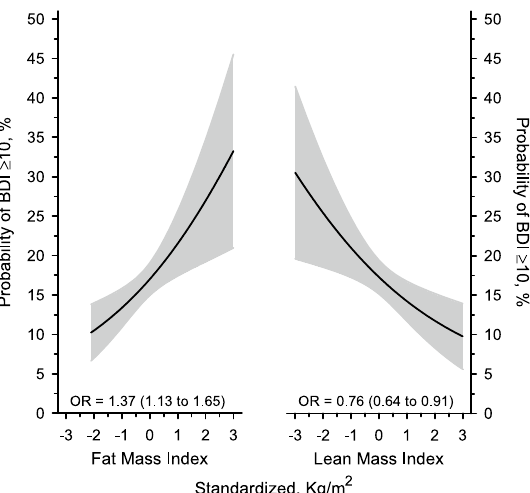
Figure 3. Relationship between BDI ≥ 10 according to body composition. BDI beck depression inventory, OR odds ratio. Odds ratio is presented per 1-SD. Models have been adjusted for age, sex, education, and fasting plasma glucose